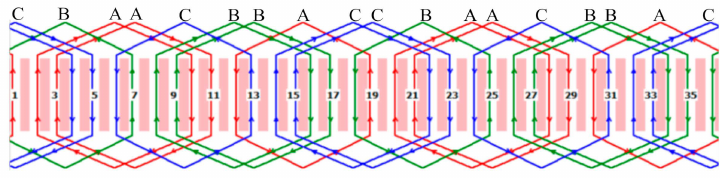
Figure 10. Schematic diagram of single layer cross winding. Table 3. Mechanical angle of each phase wind